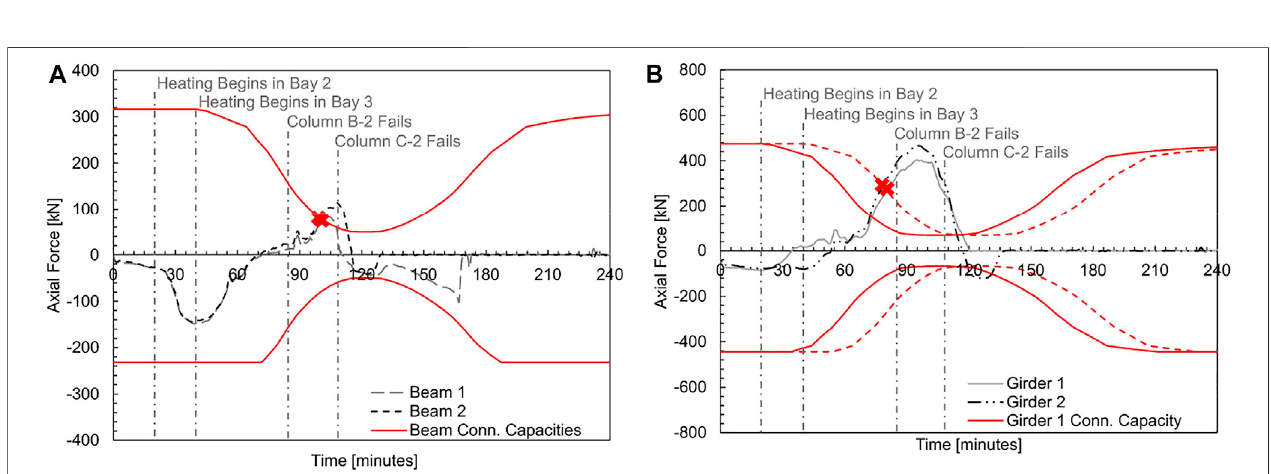
FIGURE 11 | Axial force histories and connection capacities for (A) beams and (B) girders connecting to column C-2 for Fire Scenario #2.